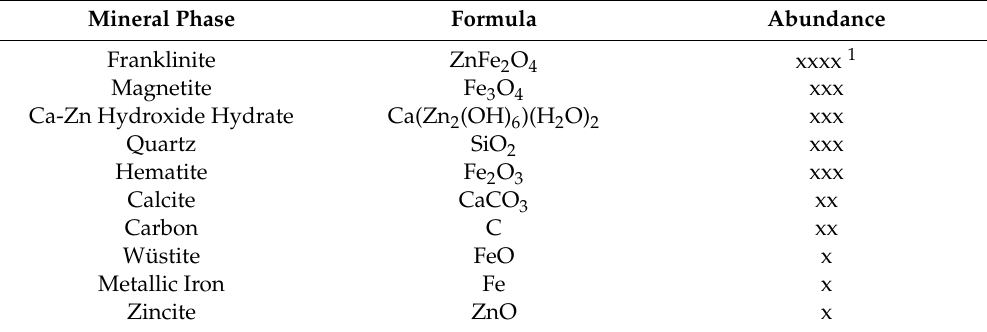
Table 2. Mineralogical analysis of reference sample (C / O =